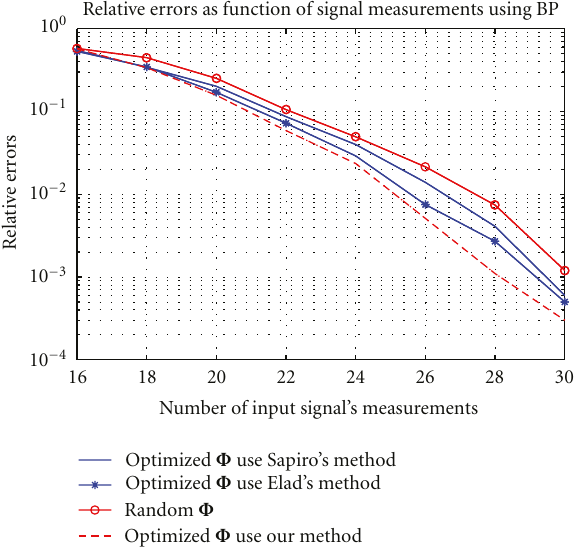
Figure 3: CS relative errors as function of the number of measurements using